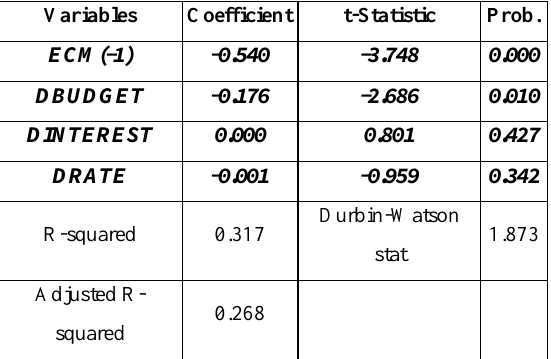
Table 4 Results of Short-Run Relationships